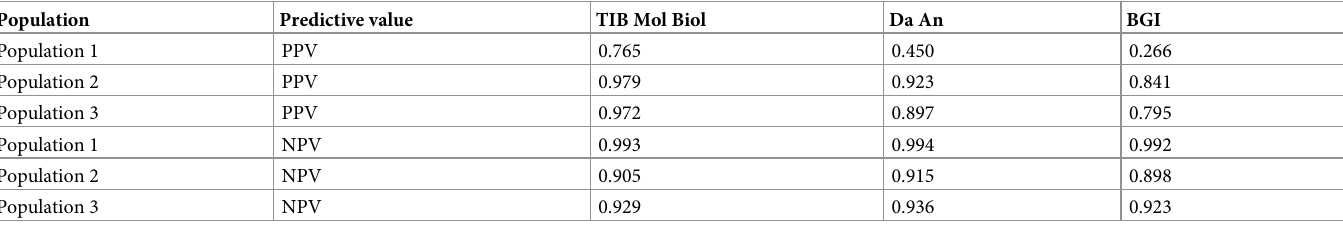
Table 7. Predictive values of three tests comparing with three different populations for SARS-COV-2 infection in Addis Ababa, Ethiopia, 2021.